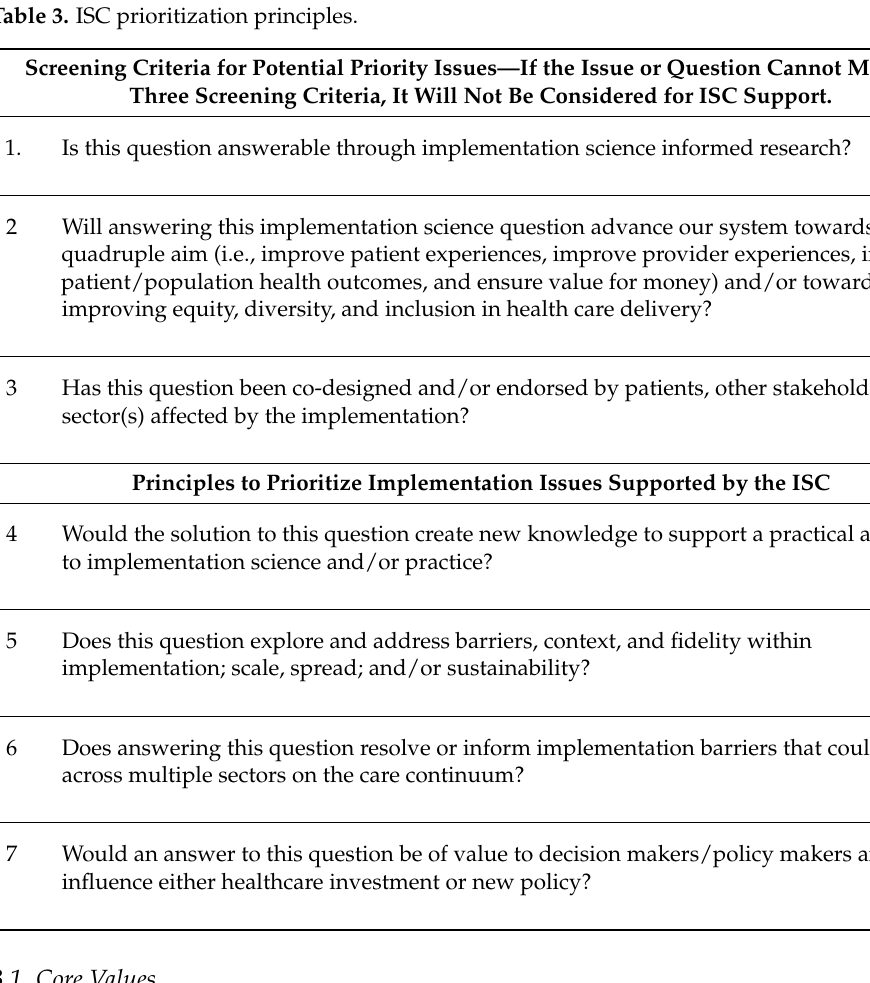
Table 3. ISC prioritization